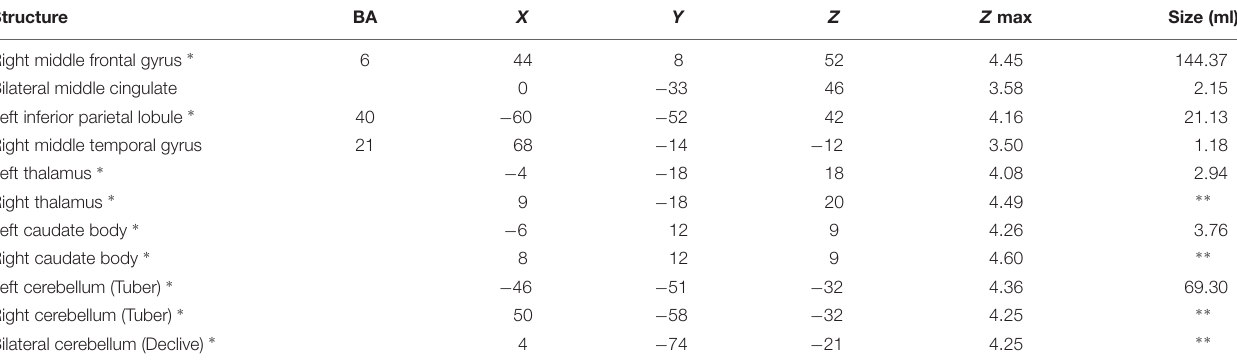
TABLE 2 | Regions showing a negative correlation between absolute CBF and age. Structure